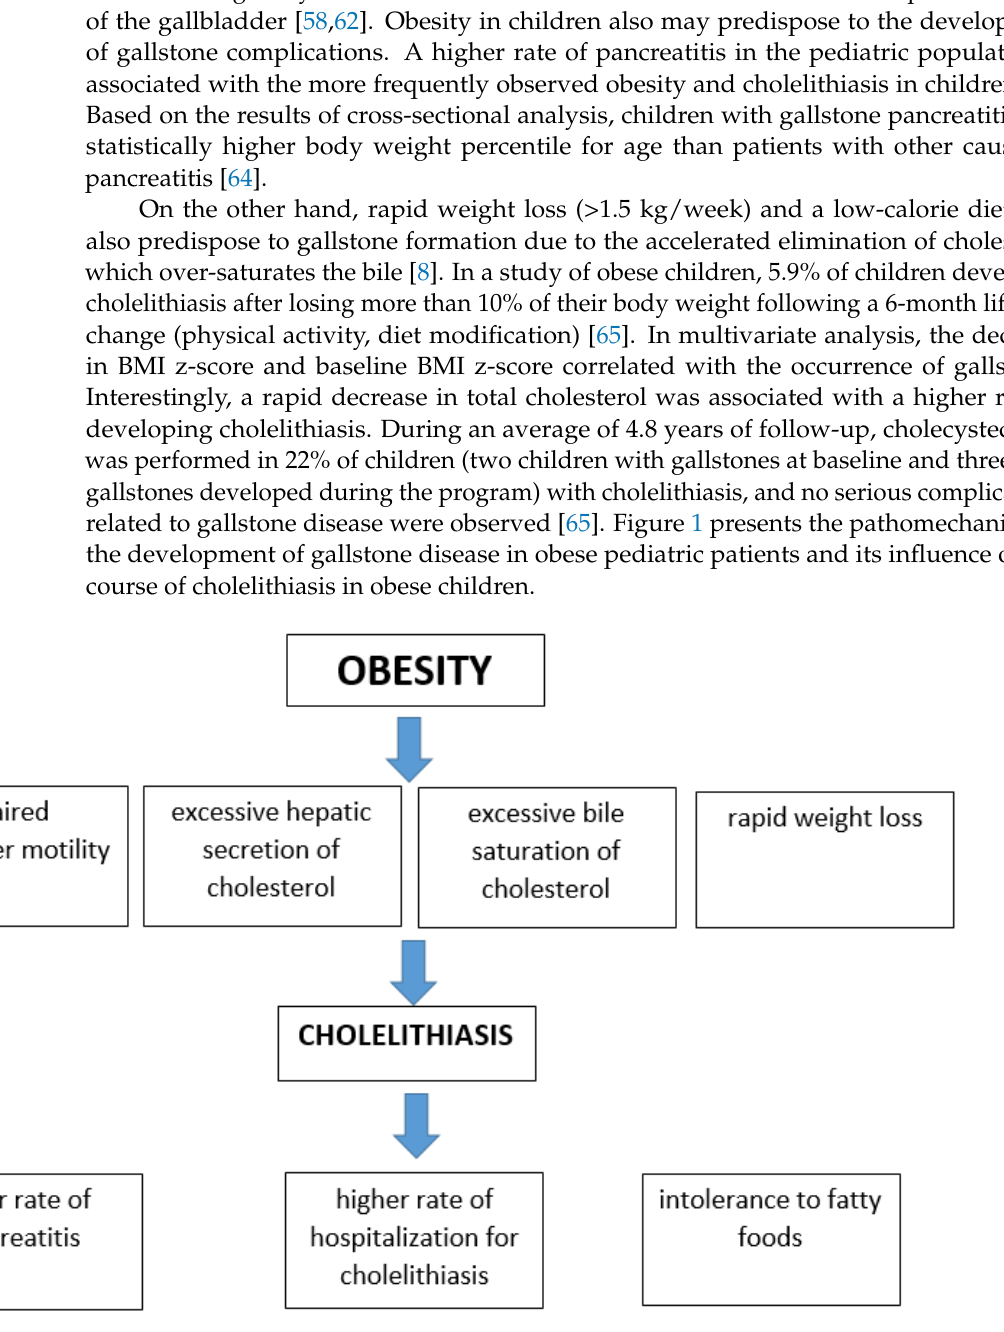
Figure 1. Influence of obesity on the development of gallstone disease and its complications in chil- dren.